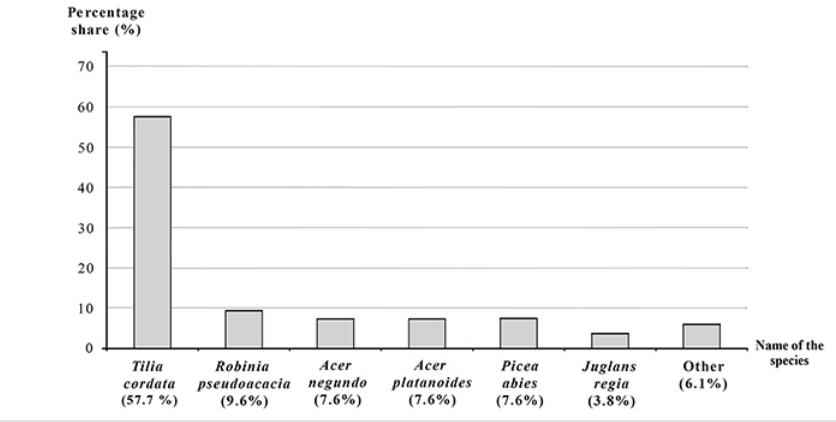
Fig. 3 Percentage share of trees in Felin Manor Park in 1981.